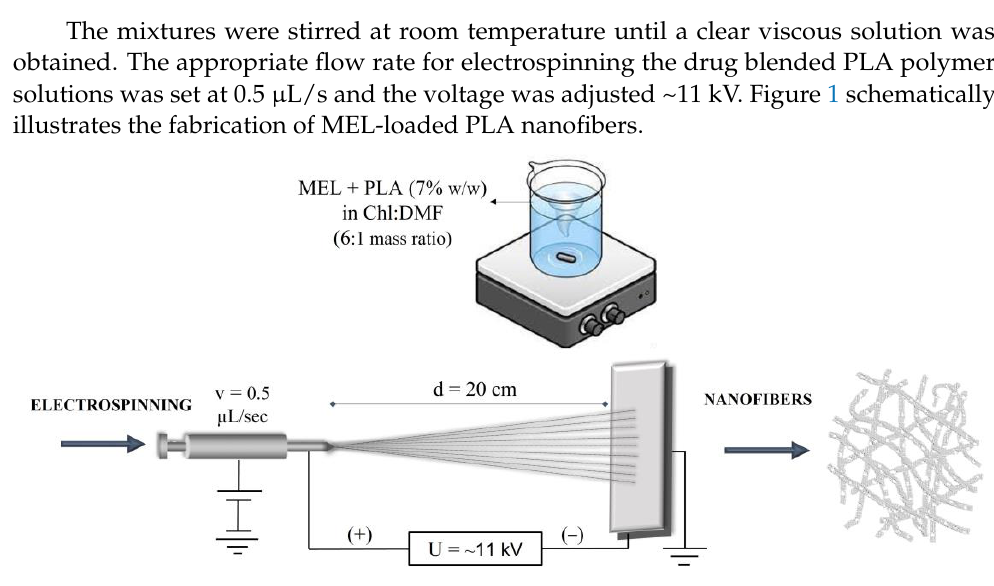
Figure 1. Schematic illustration of the production of melatonin-loaded PLA nanofibers.